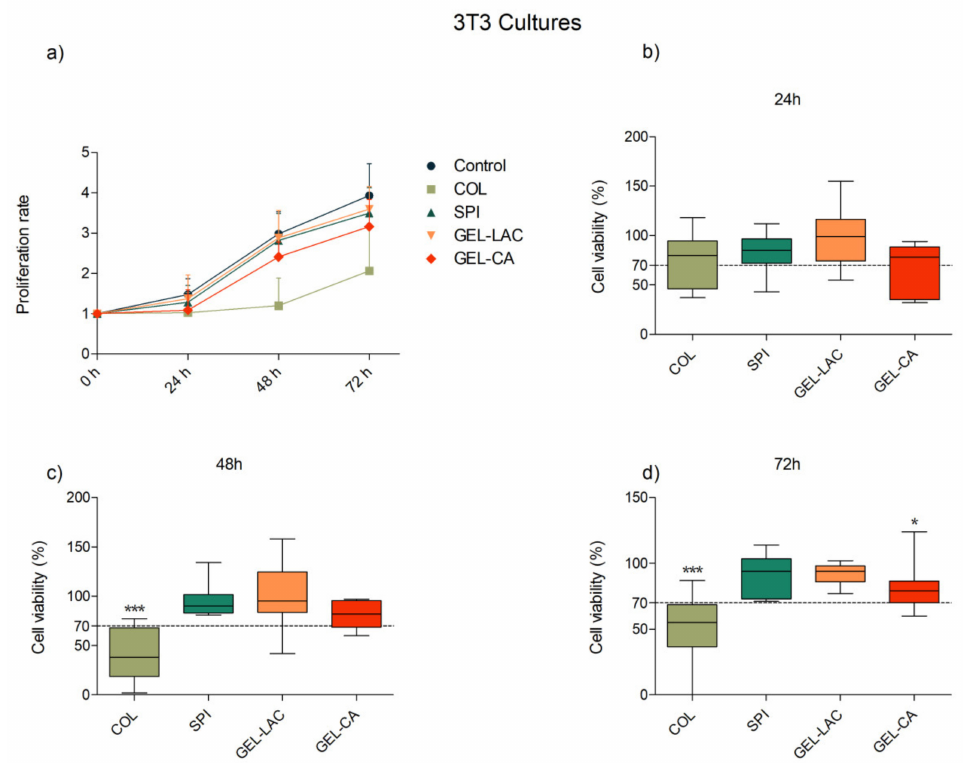
Figure 4. Effects of film composition on the ( a ) proliferation and ( b – d ) viability of 3T3 cells. Cells seeded in p96-well plates were exposed to each film for 24, 48, and 72 h. Cells seeded on wells without any biomaterial were used as controls. Proliferation results are represented as proliferation rate mean ± SD of viable cells compared with viable cells at t = 0 h. Viability results are expressed as percentages of viable cells in relation to control wells (100% viability). The lines drawn inside each box represent the medians of viability values of each film. Statistically significant differences showed differences with respect to control (* p < 0.05, ** p < 0.01, *** p < 0.001; n =